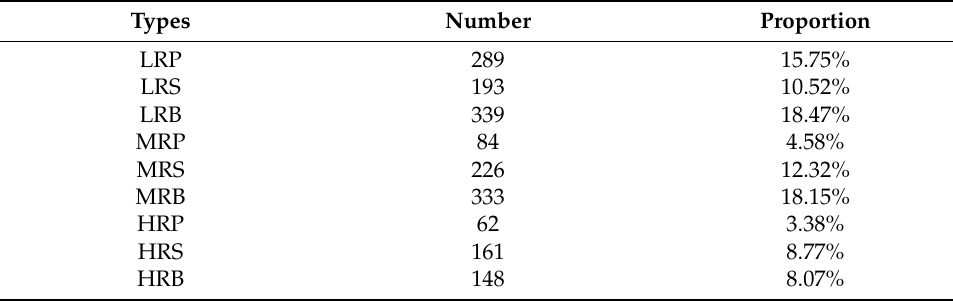
Table 2. The number of different types of urban block